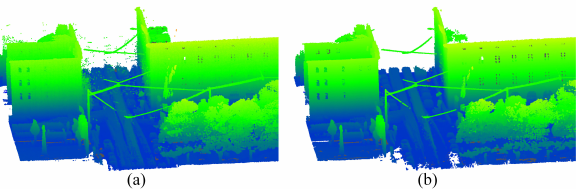
Figure 6. Two oblique mounted laser scanners of the MLS system.